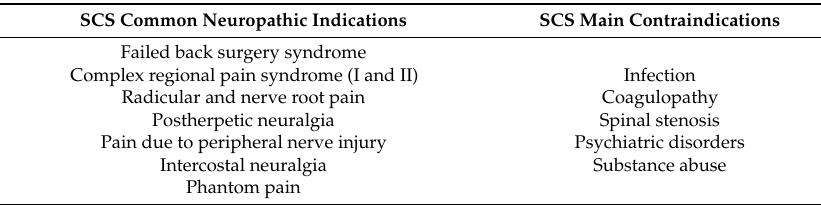
Table 1. Common SCS indications and